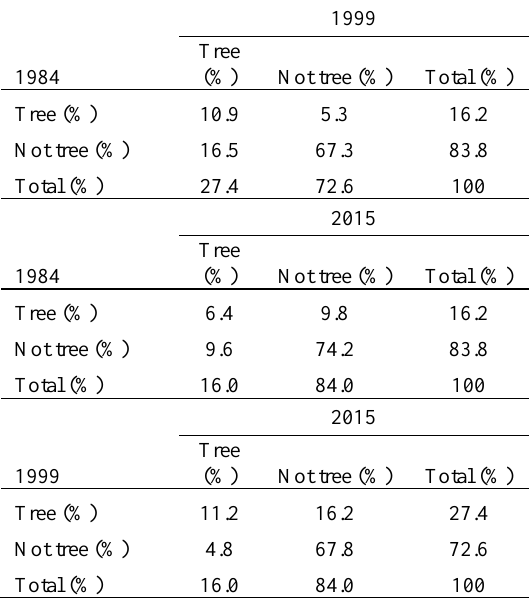
Table 2. Urban tree canopy cover transitions between